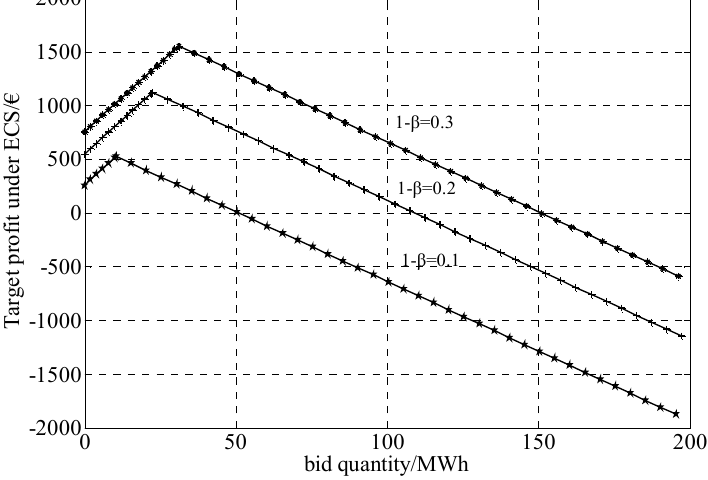
Figure 5. Target profit under the CPS versus bid quantity with different 1 − β